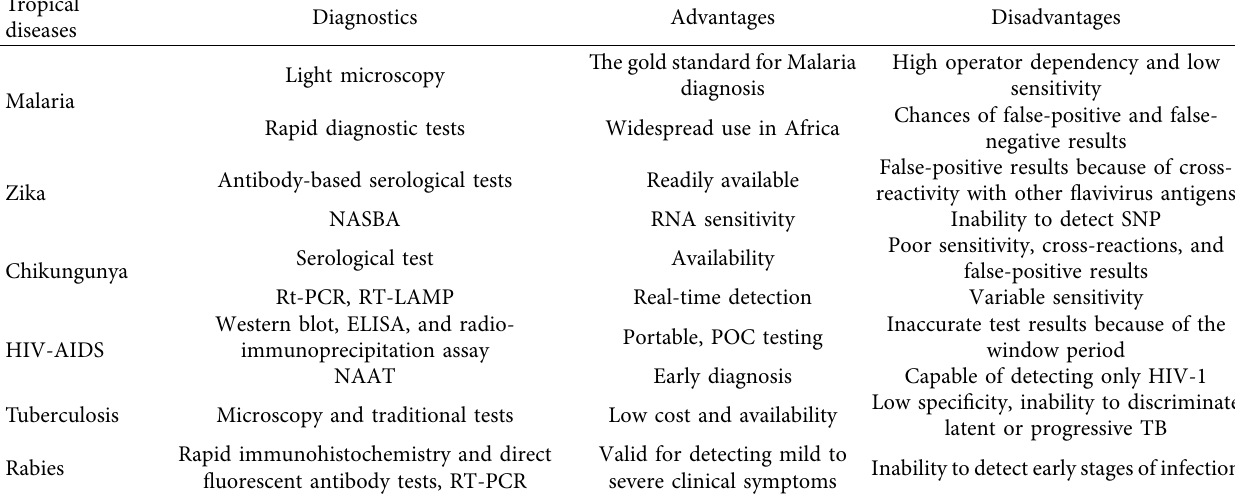
Table 2: Advantages and disadvantages of non-CRISPR-based detection techniques used in diagnosing tropical diseases. Tropical